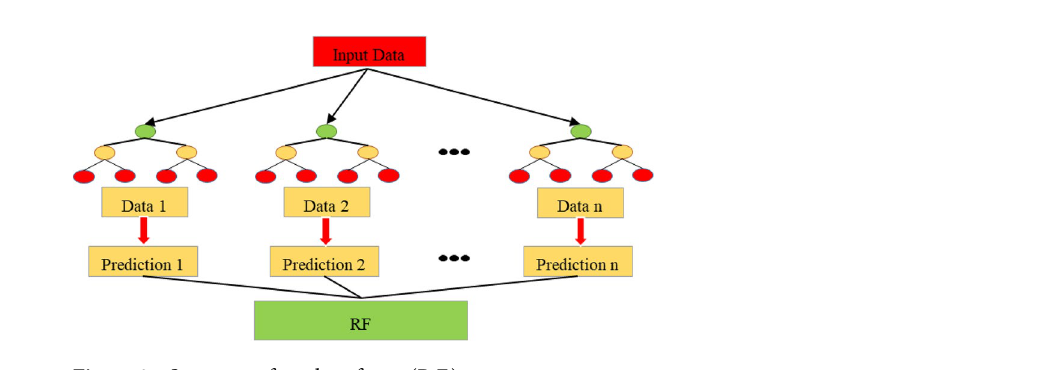
Figure 3. Structure of random forest